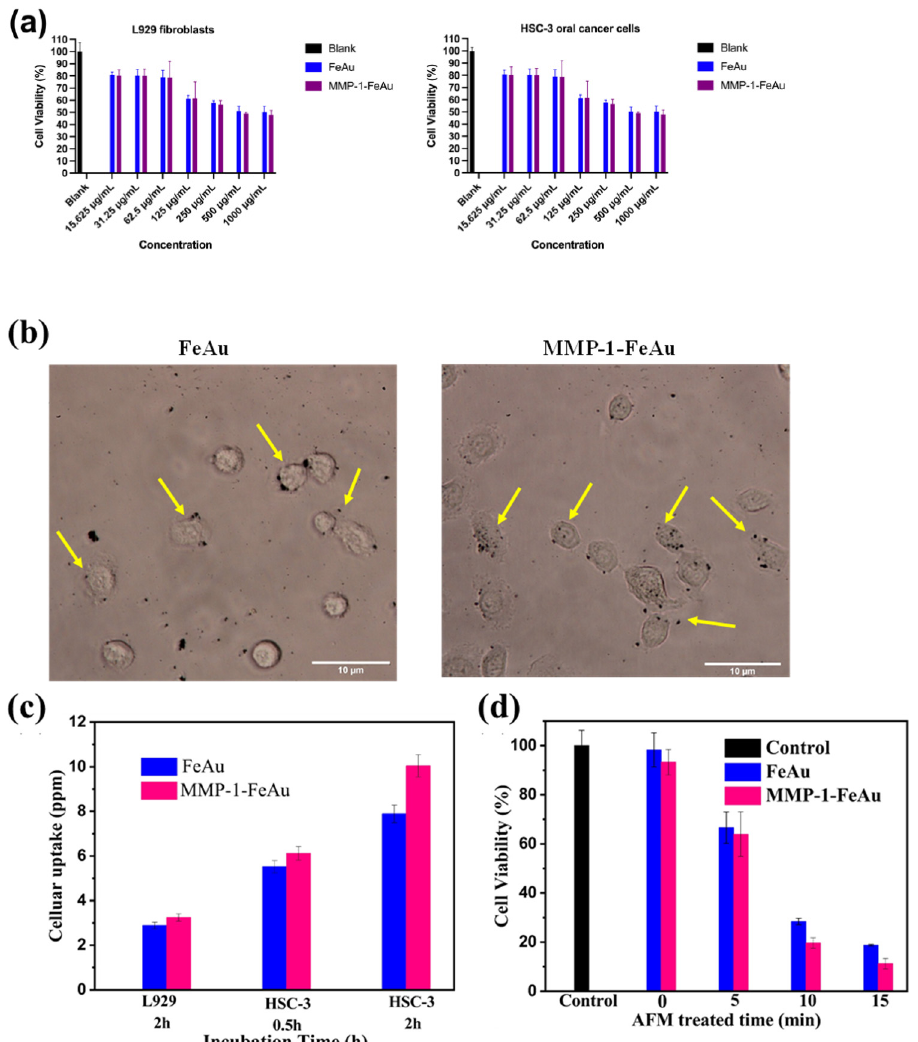
Figure 5. Cell responses of FeAu NPs and MMP-1 antibody-conjugated FeAu NPs. ( a ) Cellular viability of L929 and HSC-3 by the MTT assay (n = 3); ( b ) bio-TEM micrographs of human oral squamous carcinoma incubated with FeAu and MMP1-FeAu over different time periods; ( c ) quantification of cellular uptake of FeAu NPs and MMP1-FeAu NPs in HSC-3 cells and L929 cells analyzed by ICP-AES, ( d ) FeAu NPs and MMP1-FeAu NPs stimulated magnetically.